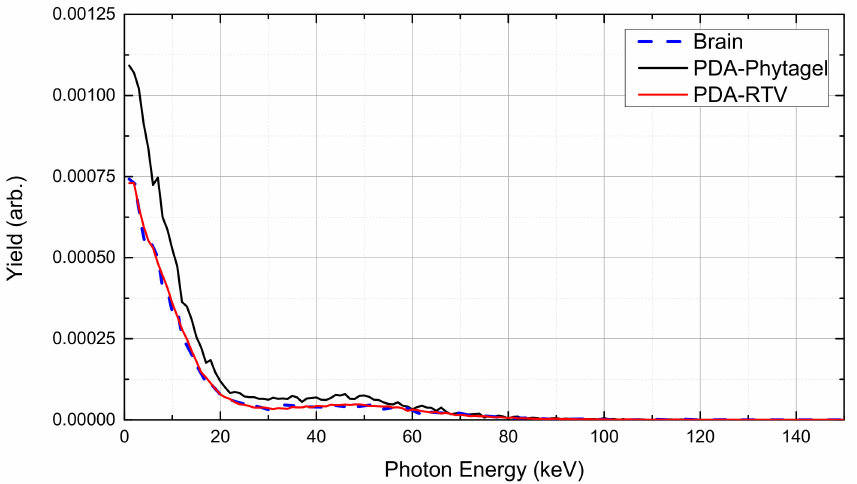
Figure 6. Absorbed photons spectra of the simulated brain (dashed blue line), the PDA-Phytagel dosimeter (black line), and the PDA-RTV dosimeter (red line).